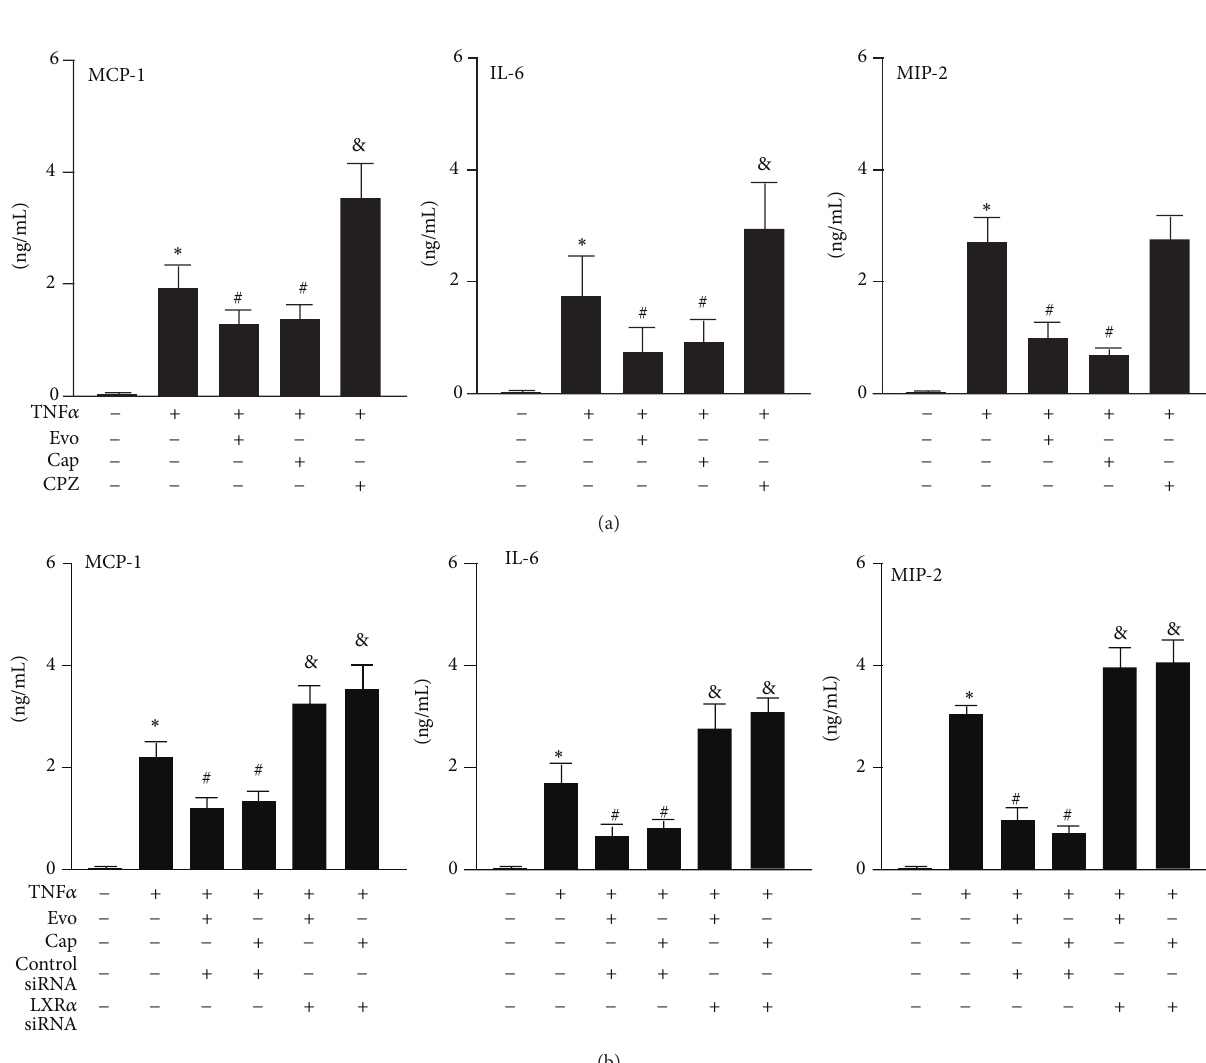
Figure 8: Knockdown of LXR 𝛼 diminishes the protective effect of TRPV1 agonists against TNF- 𝛼 -induced inflammation in macrophages. (a) BMDMs were pretreated with capsazepine (10 𝜇 M) for 1h or (b) transfected with control siRNA (50 nmol/L) or LXR 𝛼 siRNA (50 nmol/L) for 24 h, then incubated with vehicle (DMSO), evodiamine (500nM), and capsaicin (10 𝜇 M) with or without TNF- 𝛼 (10ng/mL) for an additional 18h.ELISAoflevelsofMCP-1,IL-6,andMIP-2intheculturemedium.Dataaremean ± SDfrom5independentexperiments. ∗ 𝑃 < 0.05 versus vehicle-treated cells, and # 𝑃 < 0.05 versus TNF- 𝛼 -treated cells, and & 𝑃 < 0.05 versus TNF- 𝛼 -treated group with evodiamine or capsaicin